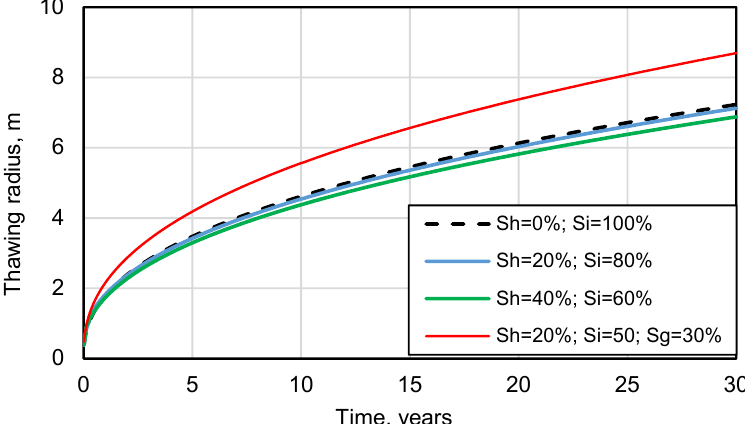
Figure 10. Time-dependent thawing radius variations in the 60–120 m depth interval at different hydrate saturations. S h , S i , and S g refer to hydrate, ice, and gas saturation, respectively. The thaw size in permafrost within the 60 ‒ 120 m (Figure 11) increased almost linearly with time (R 2 ≥ 0.99 for all fluid types). This is an illustration of quasiparabolic self-similar asymptotic thaw behavior after short initial heating till the end of the 30 yr well lifespan.